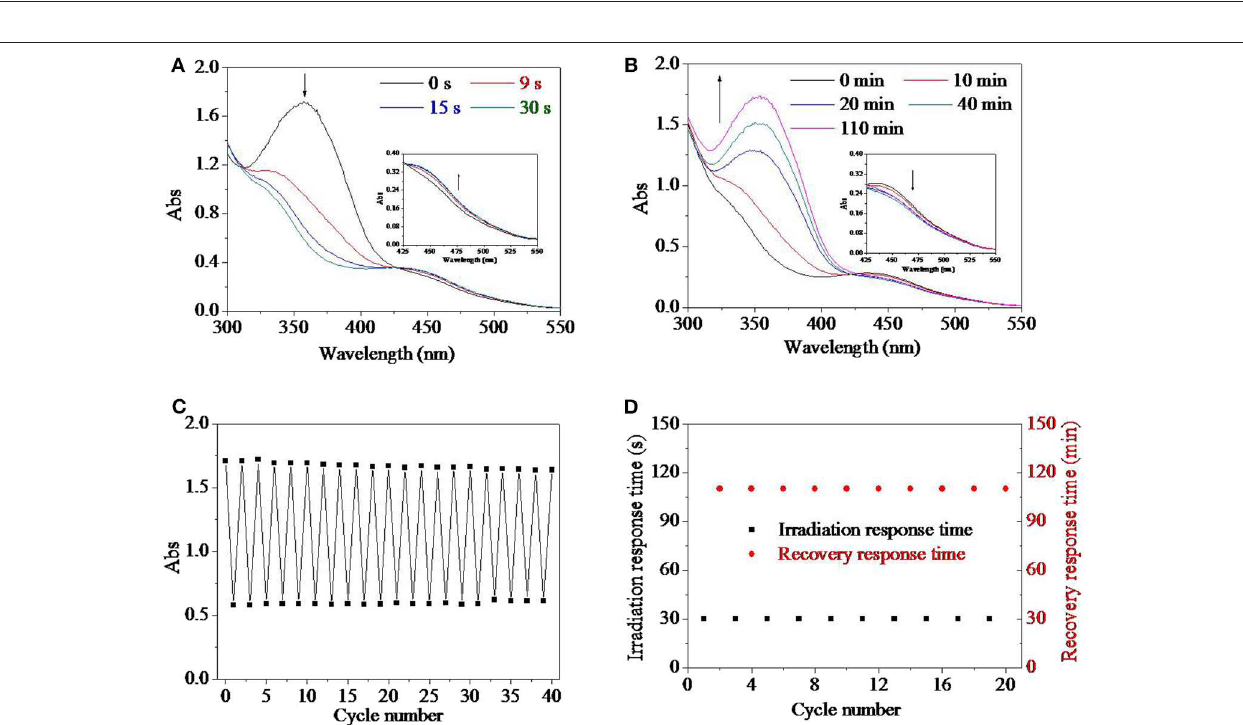
FIGURE 2 | UV spectra of the HEMA-AZO copolymer dimethylsulfone (DMSO) solution as a function of (A) irradiation time and (B) recovery time. (C) Absorbance at 360nm of HEMA-AZO copolymer DMSO solution as a function of cycle number. (D) Irradiation response time under UV irradiation and recovery response time under 73 µ W/cm 2 white light as a function of cycle number at 20 ◦